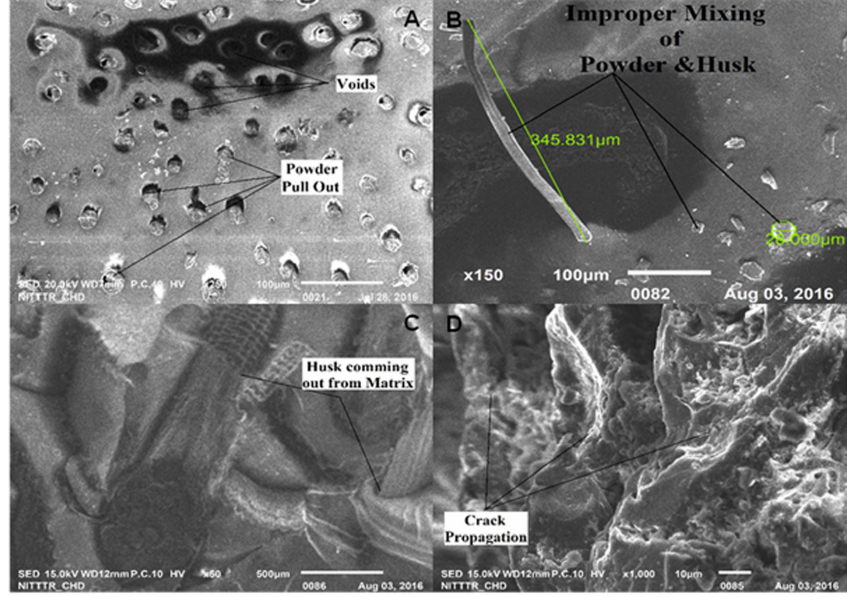
Figure 2: SEM images of (A) RH particle, (B) hybrid RH and (C-D) RH reinforced composites at 15 wt.%